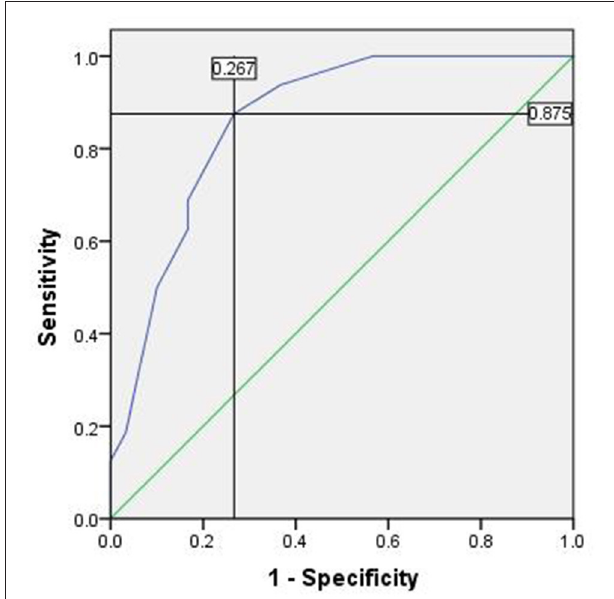
FIGURE 2 | The ROC of PSLNR for predicting APLN. Area under the curve (AUC) was 0.861, P < 0.001, 95% CI (0.757, 0.966). The cutoff value was 0.2917 and the Youden index was 0.608. ROC, receiver operating characteristic curve; PSLNR, positive sentinel lymph node ratio; APLN, additional positive lymph node; AUC, area under the curve.